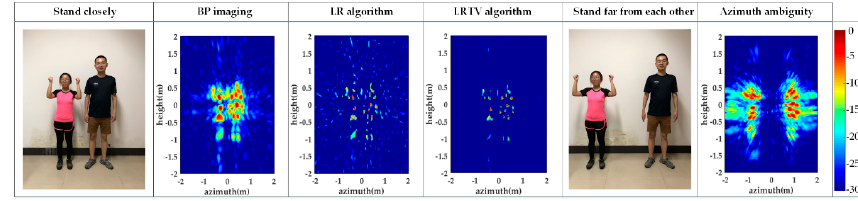
Figure 13. The enhanced imaging methods are used in complicated scenarios.